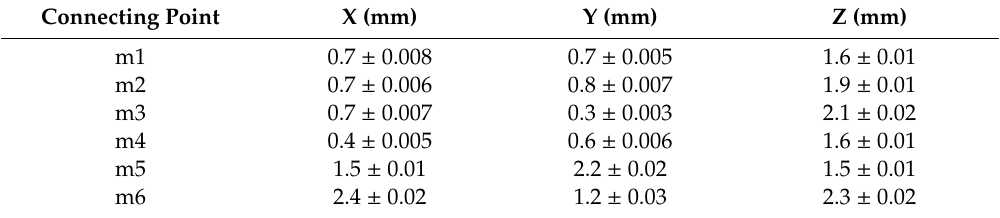
Table 2. RMSE values during the first test (platform elevating along the Z axis) computed from data measured by DORIS platform and by the cameras system. Mean value for each axis ± standard error.